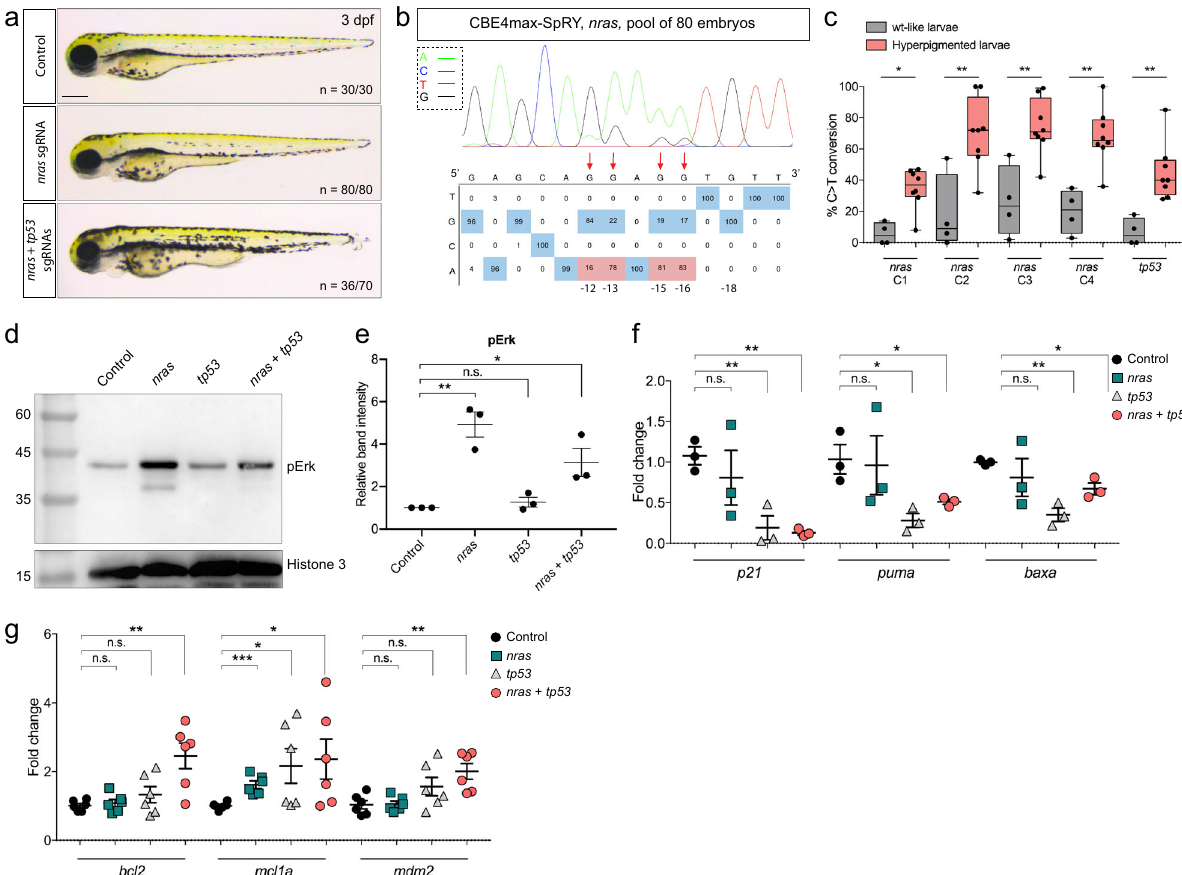
Fig. 4 Endogenous activation of nras oncogene and knock-out of tp53 tumor-suppressor gene led to an increase in melanocyte numbers. a Lateral view of 3 dpf larvae. The injected embryos edited only for nras do not present any defects, whereas 50% of the injected embryos targeted for nras and tp53 were hyperpigmented. Scale bar = 100 µ m. b DNA sequencing chromatogram of the targeted nras gene from a pool of 80 injected embryos with the CBE4max- SpRY mRNA and the nras NAN sgRNA. C-to-T conversion shows 83% of ef fi ciency for the C in position 16, 81% for the C in position 15, 78% for the C in position 13, and 16% for the C in position 12 bp away from the PAM. Numbers in the boxes represent the percentage of each base at that sequence position. In red are highlighted the base substitutions introduced by base editing while the original bases are in blue. The color code of the chromatogram is indicated in the upper left corner (Adenine green, Cytosine blue, Thymine red, Guanine black). The distance from the PAM sequence of the targeted C base is indicated below the chromatogram. The ef fi ciencies have been calculated using EditR software 42 and chromatograms from Sanger sequencing of PCR products. c Box plot showing the base editing ef fi ciency for nras and tp53 genes for the 4 “ wt-like ” larvae and the 8 larvae with increased pigmentation from Supplementary Fig. 4. Statistical signi fi cance was determined using a two-tailed Mann – Whitney test. p value = 0.0162 ( nras C1), 0.0081 ( nras C2), 0.0081 ( nras C3), 0.0040 ( nras C4), 0.0020 ( tp53 ). The boxes range from the 25th to 75th percentiles. The box plot whiskers down to the minimum and up to the maximum value, the center shows the median, and each individual value is represented by a point. d Western blot made on 3 dpf control larvae, nras targeted larvae, tp53 targeted larvae or nras and tp53 targeted larvae using CBE4max-SpRY mRNA and antibodies targeting phosphorylated ERK1/2 (pERK) and Histone 3 as loading control. The molecular weight is in kDa. Source data are provided as a Source data fi le. e Dot plot showing the means and standard errors of the mean (SEM) of the relative band intensity of 3 independent western blots as seen in d . Statistical signi fi cance was determined using a two-tailed unpaired t test. p value = 0.0027 (**, control vs nras ), 0.3160 (n.s., control vs tp53 ), 0.0313 (*, control vs tp53 + nras ). f , g Dot plots showing the means and SEM of quantitative real-time PCR of p21 , puma , baxa ( f ) and of bcl2 , mcl1a , mdm2 ( g ) expression levels in 3 dpf control larvae, nras targeted larvae, tp53 targeted larvae or nras and tp53 targeted larvae using CBE4max-SpRY mRNA. Statistical signi fi cance was determined using a two-tailed unpaired t test. For p21 , p value = 0.4881 (n.s., control vs nras ), 0.0082 (**, control vs tp53 ), 0.0011 (**, control vs nras + tp53 ). For puma , p value = 0.8653 (n.s., control vs nras ), 0.0196 (*, control vs tp53 ), 0.0465 (*, control vs nras + tp53 ). For baxa , p value = 0.4695 (n.s., control vs nras ), 0.0015 (**, control vs tp53 ), 0.0121 (*, control vs nras + tp53 ). For bcl2 , p value = 0.5810 (n.s., control vs nras ), 0.2163 (n.s., control vs tp53 ), 0.0033 (**, control vs nras + tp53 ). For mcl1a , p value = 0.0004 (***, control vs nras ), 0.0445 (*, control vs tp53 ), 0.0423 (*, control vs nras + tp53 ). For mdm2 , p value = 0.8956 (n.s., control vs nras ), 0.1014 (n.s., control vs tp53 ), 0.0037 (**, control vs nras + tp53 ). n = 3 for ( f ) and n = 6 for ( g ) independent